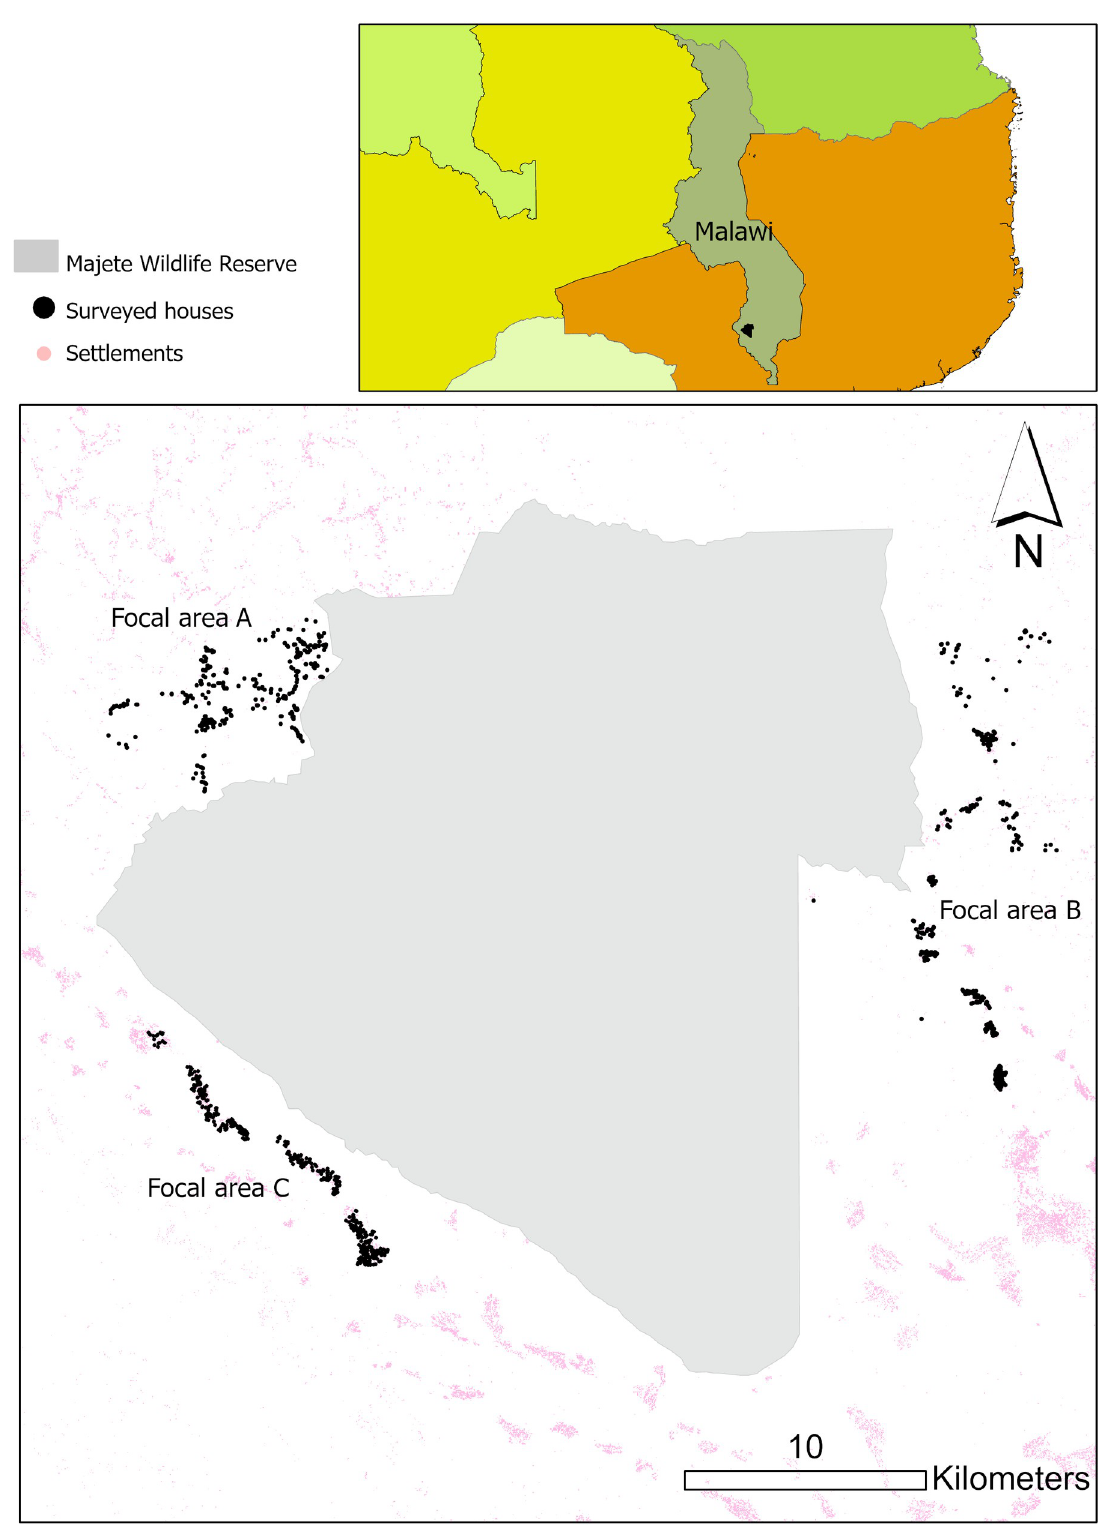
Fig 1. Majete Malaria Project focal areas. Map was made using ArcGIS Pro 2.7.0 (https://www.esri.com/en-us/arcgis/products/arcgis- pro/resources). Source settlements data: High Resolution Settlement Layer—Facebook Connectivity Lab and Center for International Earth Science Information Network—CIESIN—Columbia